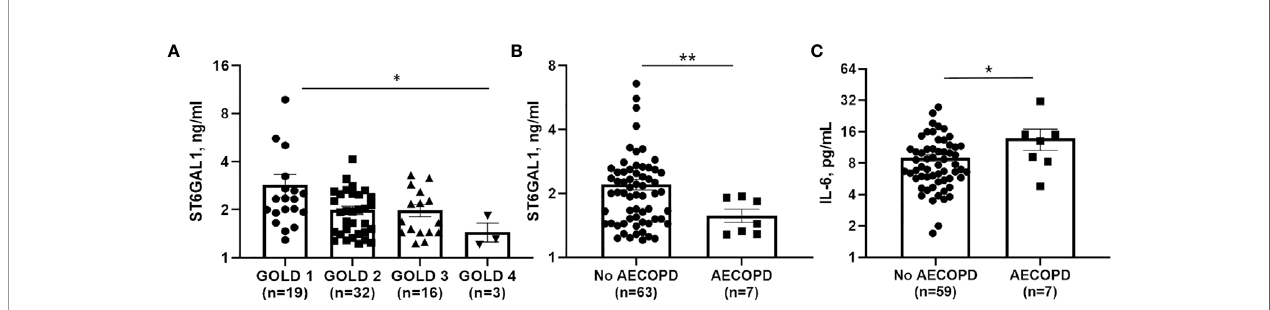
FIGURE 6 | Circulating ST6GAL1 levels are lower in COPD patients and correlate with poor outcomes. (A) GOLD group status 1-4 and associated levels of ST6GAL1 in a COPD patient cohort. Circulating levels of ST6GAL1 (B) and IL-6 (C) and their respective association with acute exacerbations in COPD. Patients were classi fi ed based on severity of the COPD using the Global Initiative for Chronic Obstructive Lung Disease (GOLD) guidelines (30846476), which are as follows: GOLD 1: Mild (FEV1 >= 80% predicted); GOLD 2: Mod (FEV1 between 50 and 79% predicted); GOLD 3: Severe (FEV1 between 30 and 49% predicted); and GOLD 4: Very severe (FEV1 <30% predicted). Shown are the mean ± SEM, where n = subjects per group. *p < 0.05 and **p < 0.01.